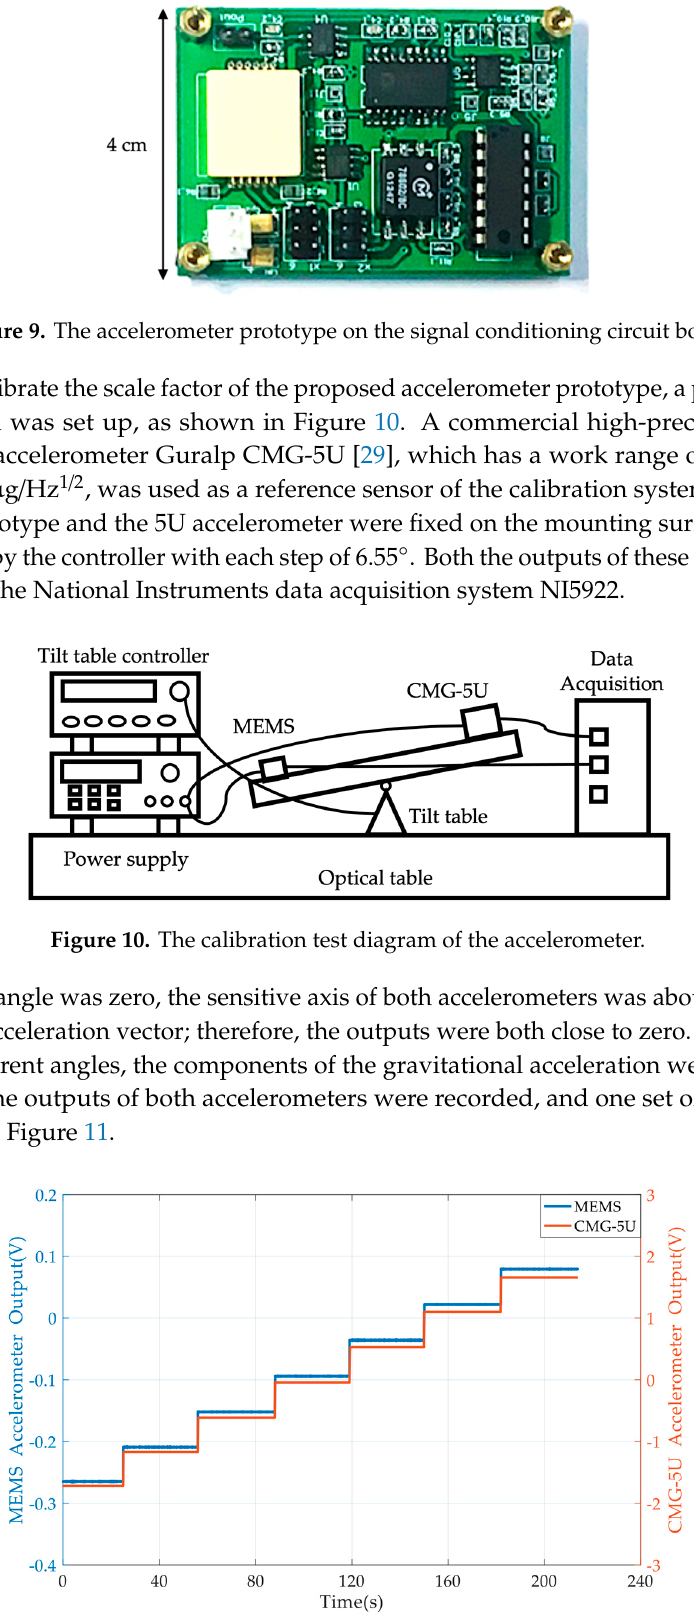
Figure 11. Outputs of both CMG-5U and the MEMS accelerometer under tilting.